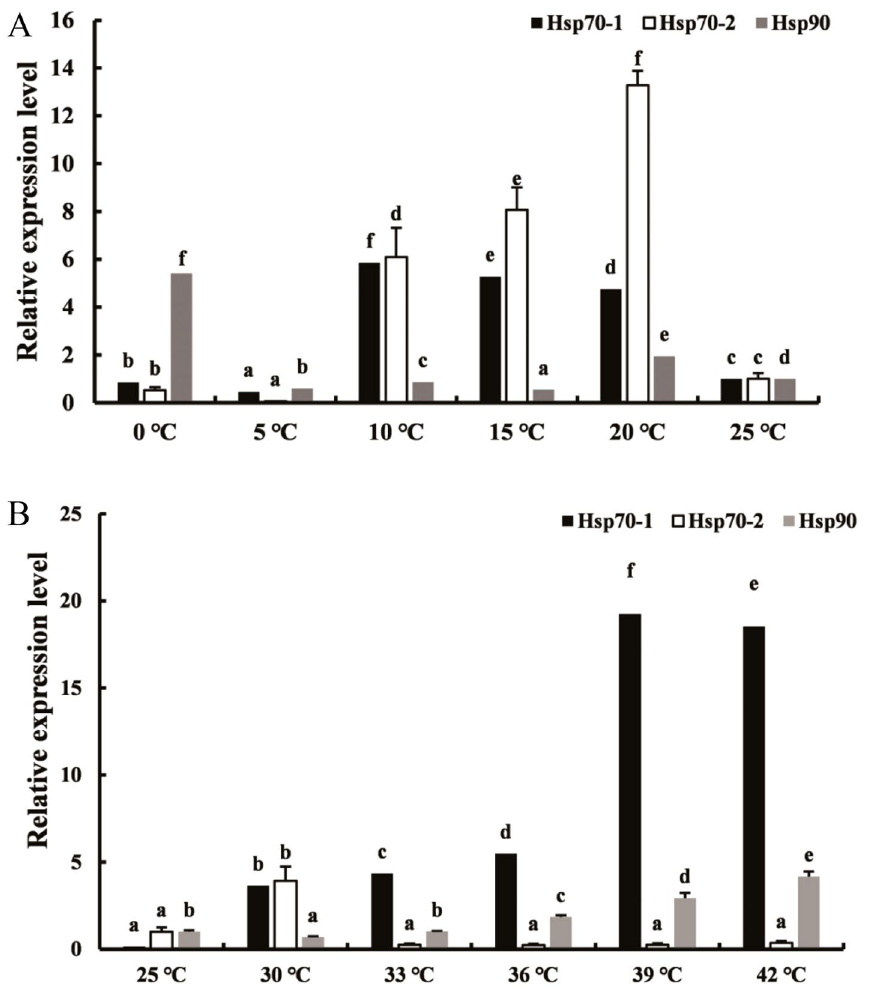
Figure 5. ( A ) Comparative quantitative RT-PCR analyzed of the relative expression of TpHSP70-1 , TpHSP70- 2 and TpHSP90 at low temperatures. Control: 25 ℃ ; Low heat shock temperature: 0, 5, 10, 15, 20 ℃ . ( B ) Comparative quantitative RT-PCR analyzed of the relative expression of TpHSP70-1 , TpHSP70-2 and TpHSP90 at high temperatures. Control: 25 ℃ ; High heat shock temperature: 30, 33, 36, 39, 42 ℃ . Each temperature treatment was three replicates. Data were represented as the mean ± SD (n = 200). Letters above columns indicate levels of difference significance at P < 0.05. The same letters are not significantly different, P >